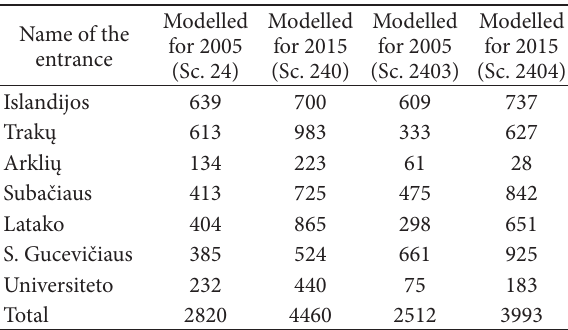
Table 3. Transport flows on the main entrance to the old town